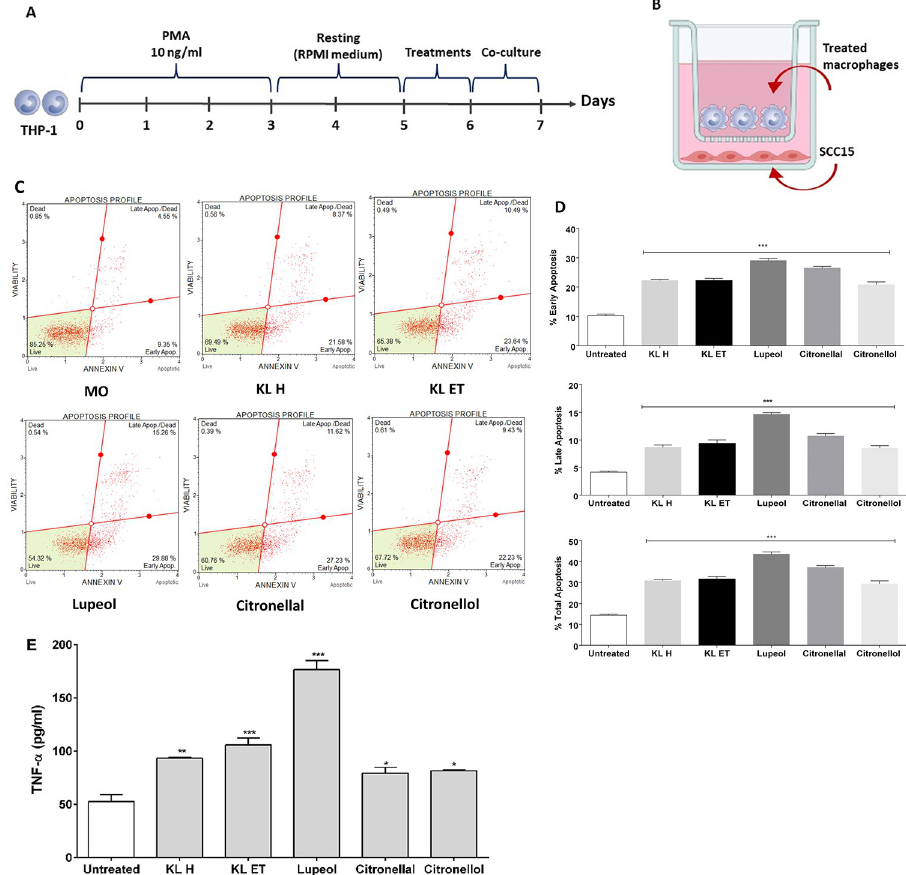
Fig 9. SCC15 co-cultured with differentiated macrophages. (A and B) Schematic diagram for THP-1 differentiation and co-culture condition in transwell plates. (C and D) SCC15 apoptosis analysis after co-culture with crude KL extracts and their compound treated macrophages. (E) TNF- α concentrations in the supernatants of macrophages harvested from the upper chamber. Bar graphs are represented as means ± SEM. � p � 0.05, �� p � 0.01 and ��� p � 0.001 compared to the untreated control